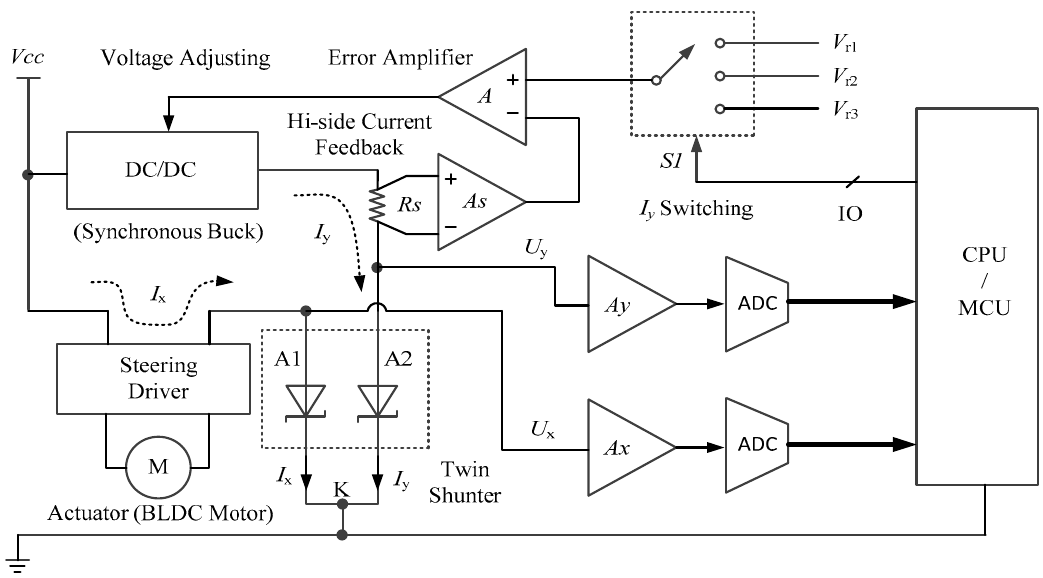
Figure 7. Circuit design of large dynamic current detection based on twin nonlinear device.